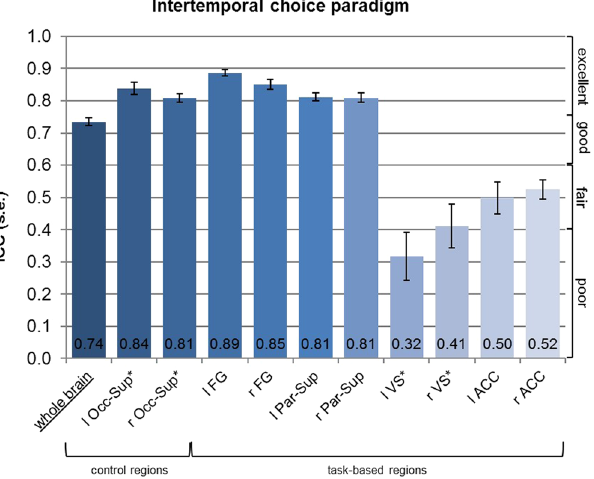
Figure 1. Results of ICC analyses for the intertemporal choice paradigm: * These regions are based on anatomical masks (AAL). l – left, r – right, Occ-Sup – Superior occipital lobe, FG – Fusiform gyrus, ACC – Anterior cingulate cortex, Par-Sup – Superior parietal